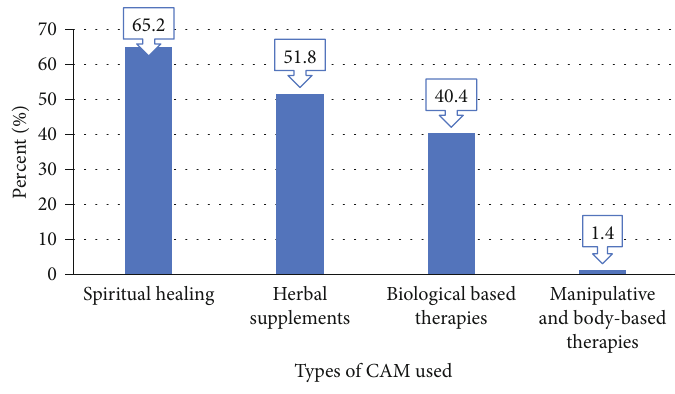
Figure 1: Frequency (%) and types of CAM therapies used during